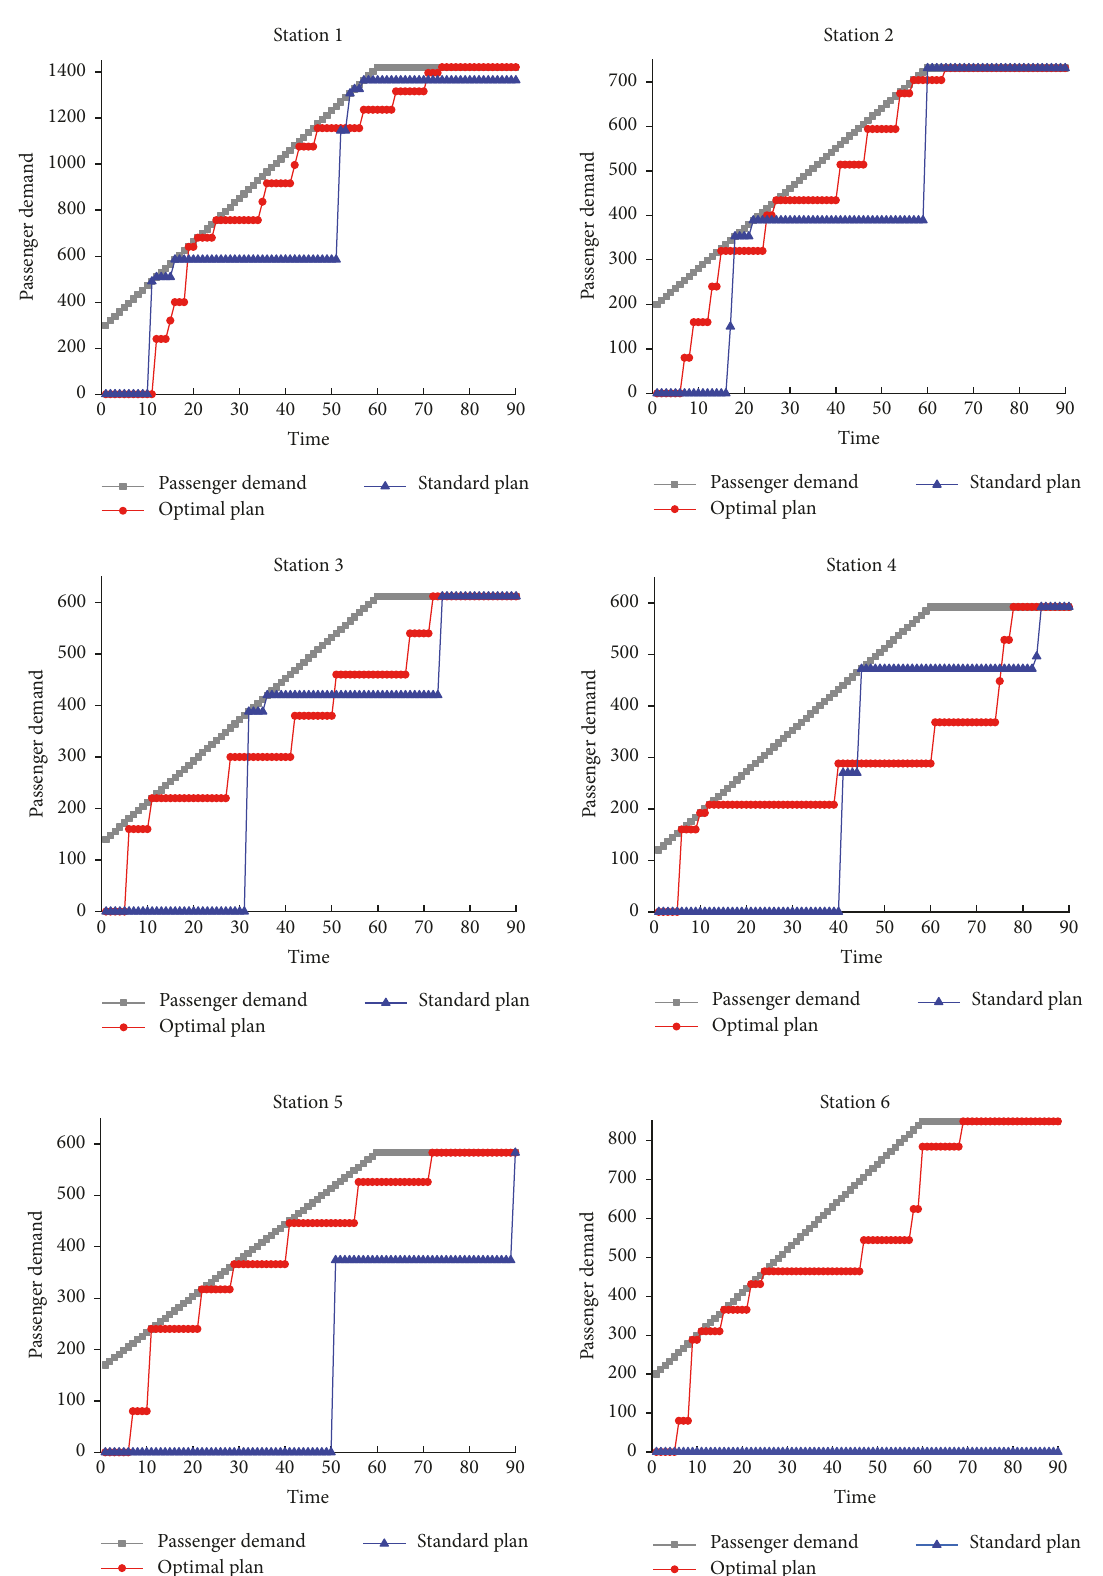
Figure 10: Cumulative arrival and boarding process at stations in upward